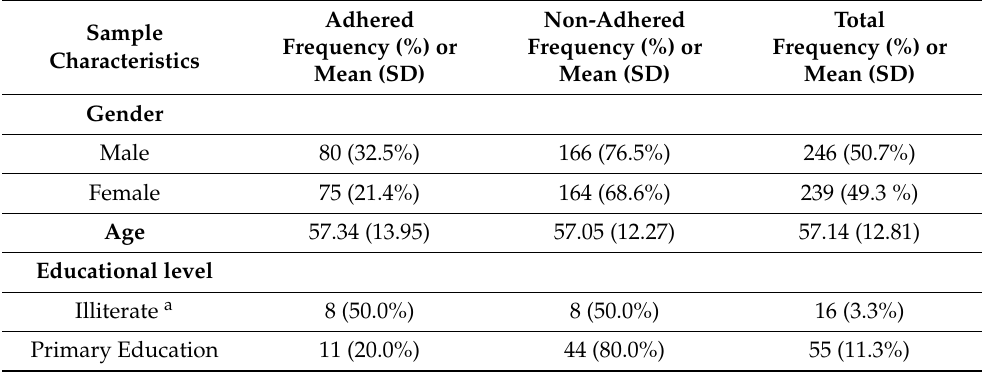
Table 1. Demographic characteristics of the participants (adhered, non-adhered and